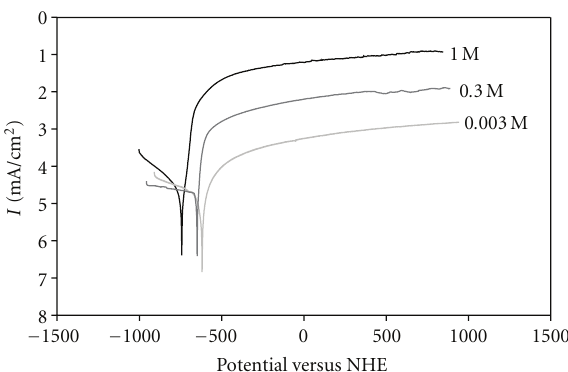
Figure 8: Potentiodynamic curves of Zn-10% Al-1.5% Cu alloy at 25 ◦ C under three di ff erent solutions concentration of 1M, 0.3M, and 0.003M NaCl.